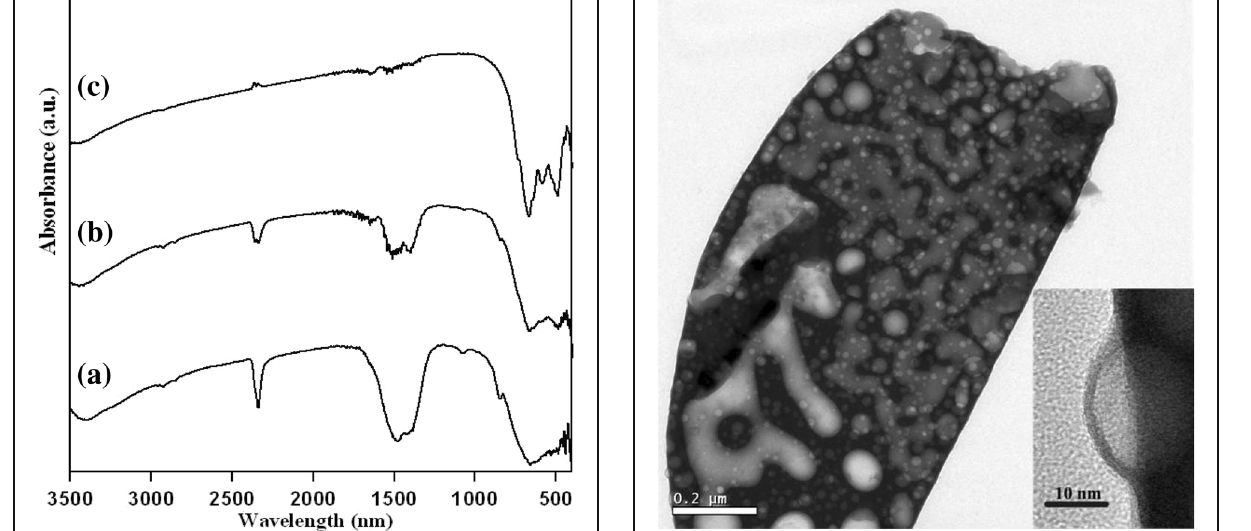
Fig. 2 FT – IR spectra of dried powders at ( a ) 600, ( b ) 700, and ( c ) 800 °C for 3 h with a composition of La 3 Ga 5.5 Nb 0.5 O 14